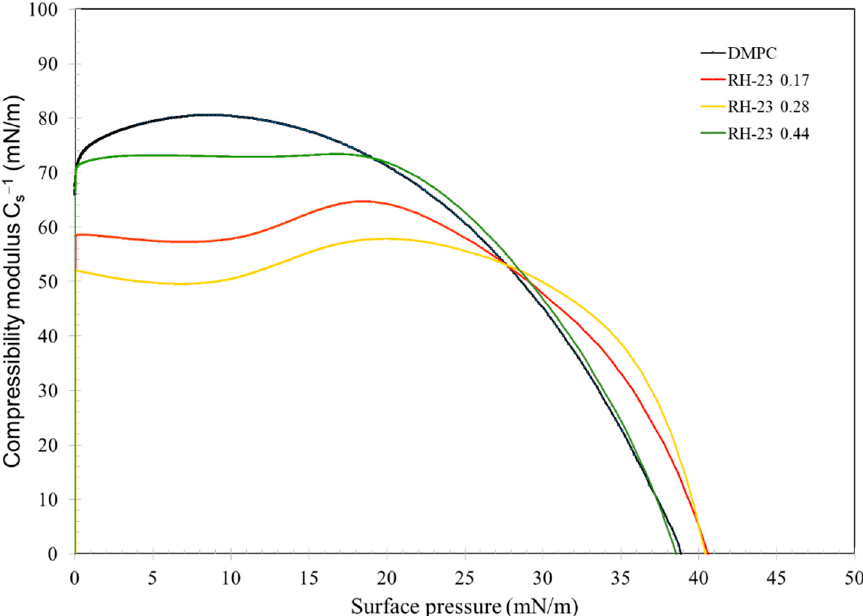
Figure 4. Compressibility modulus curves of DMPC monolayers with RH-23 at different molar fractions in the subphase, as a function of the surface pressure. RH-23 caused a decrease of the compressibility modulus of the DMPC monolayer.